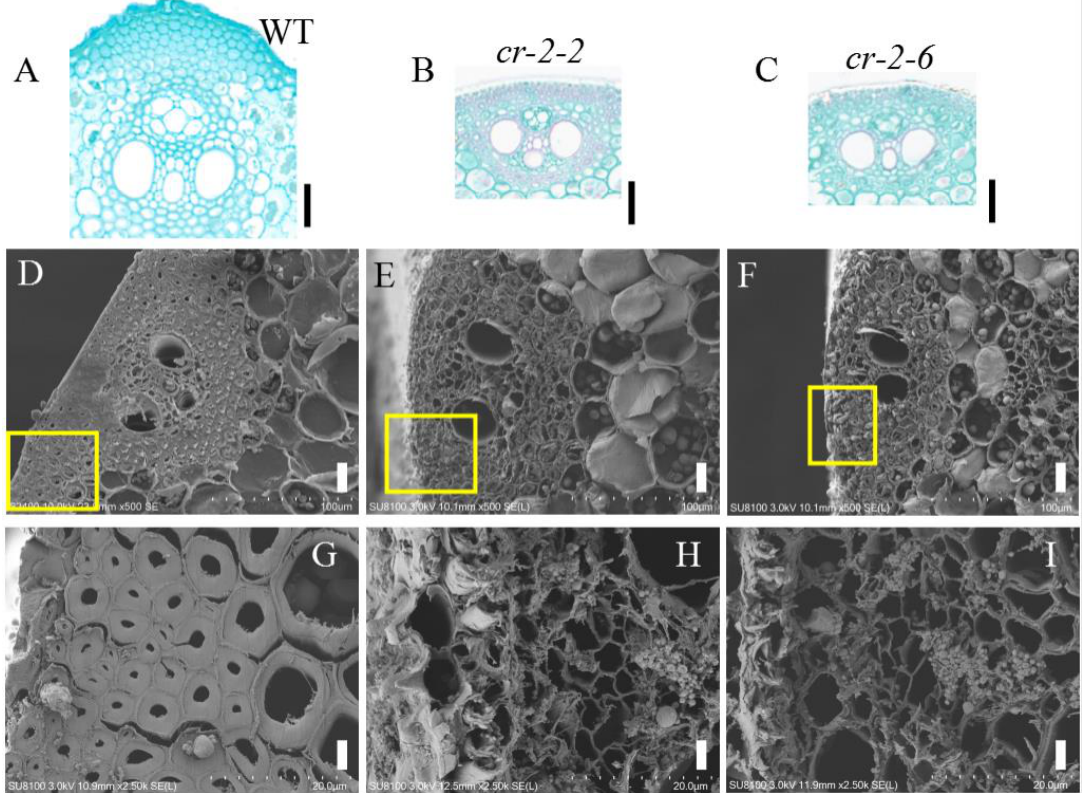
Figure 4. ( A – C ) Enlarged images of paraffin sections of stem epidermis of wild-type Pingtangheinuo and mutant cr-2-2 and cr-2-6 plants. Bar = 50 µm. Scanning electron microscopic images of internode cross sections of wild-type Pingtangheinuo and mutant cr-2-2 and cr-2-6 plants. ( D – F ) Transverse sections of wild-type ( D ), cr-2-2 ( E ), and cr-2-6 ( F ) internodes (bar = 20 µm). The yellow boxes in ( D – F ) are enlarged to show ( G – I ), respcetively. ( G – I ) Local enlargements of mechanical tissue of wild-type ( G ), cr-2-2 ( H ), and cr-2-6 ( I ) internodes (bar = 4 µm). 2.4.2. Gene Functional Verification by Overexpression of the OsBC17 Gene in the Brittle Stem